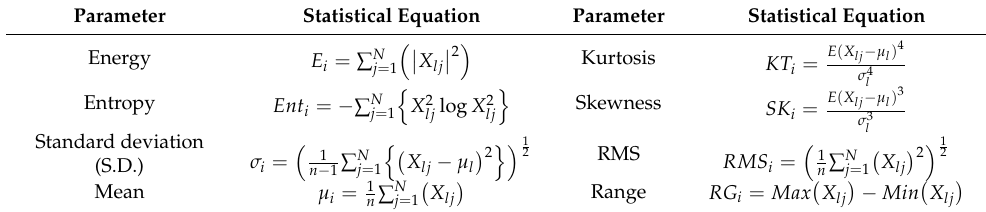
Table 2. Statistical parameter equations.